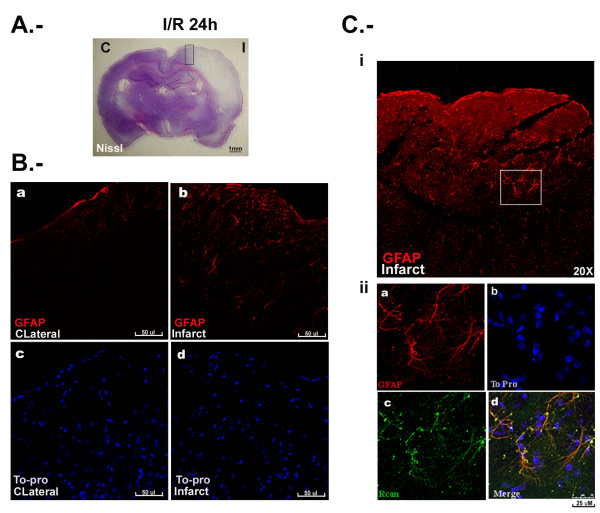
Regulator of calcineurin 1 (Rcan1) expression colocalizes with glial fibrillary acidic protein (GFAP)-positive cells during transient focal brain ischemia. Coronal brain sections of animals subjected to 1 h middle cerebral artery occlusion (MCAO) followed by 24 h blood reperfusion. (A) Nissl staining revealing a hypochromatic area of ischemic tissue in the infarcted (I) neocortex. (B) Immunohistochemistry showing expression of GFAP protein (red) in the contralateral hemisphere (a) and the infarcted region (b). Nuclei are revealed by staining adjacent sections with TO-PRO 3 (blue; c and d). (C) Immunohistochemistry showing the GFAP-positive area around the infarcted brain region. The boxed region is magnified in the lower panels: (a) GFAP immunostaining (red); (b) TO-PRO 3 nuclear staining (blue); (c) Rcan1 immunostaining (green); (d) overlay of (a-c). Yellow indicates GFAP-Rcan1 colocalization.